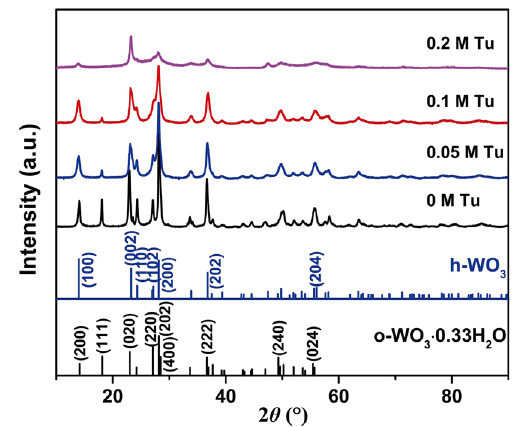
Fig. 1 XRD patterns of samples prepared in precursor with Tu concentration of 0, 0.05, 0.1, and 0.2 M.